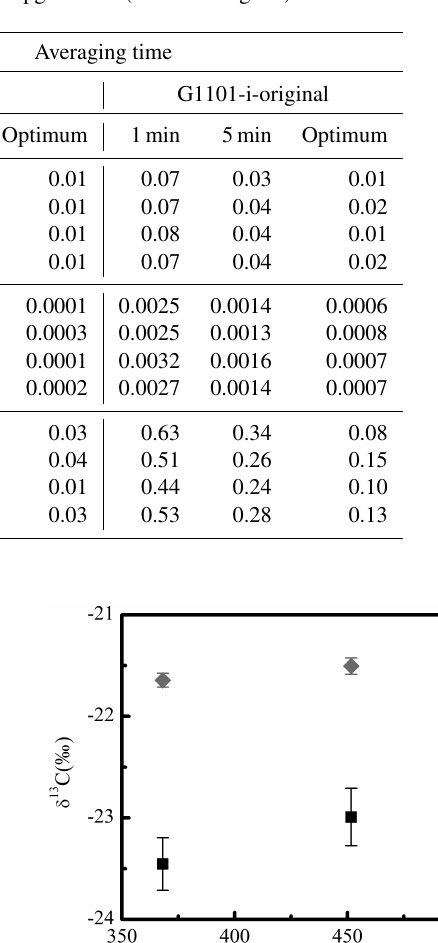
Table 1. Measurement precision (Allan deviation for 1min, 5min and optimum averaging times) from three reference gases (Ref1, Ref2 and Ref3) with 0.3 and 1Hz sampling rate for the Picarro G1101-i before upgradation (G1101-i-original) and G2201-i analyzers.